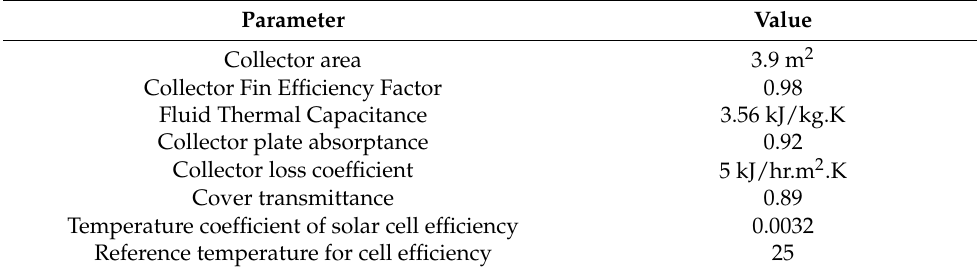
Table 7. PVT parameters for modeling in